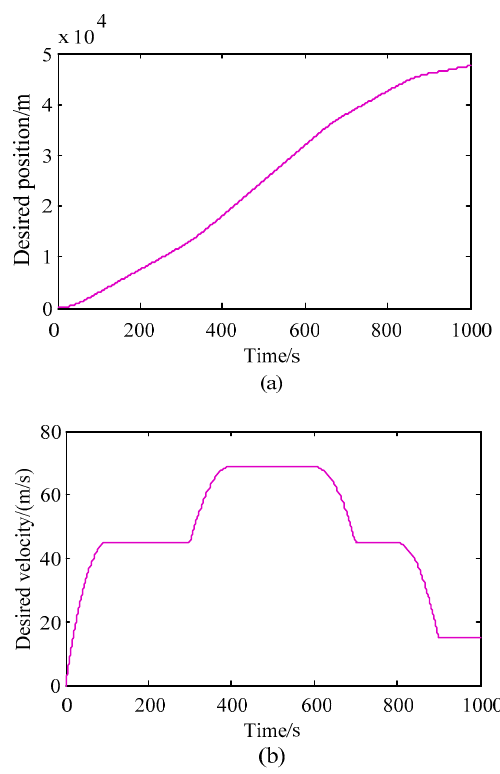
Figure 4. Desired position and velocity: ( a ) desired position, ( b ) desired velocity.